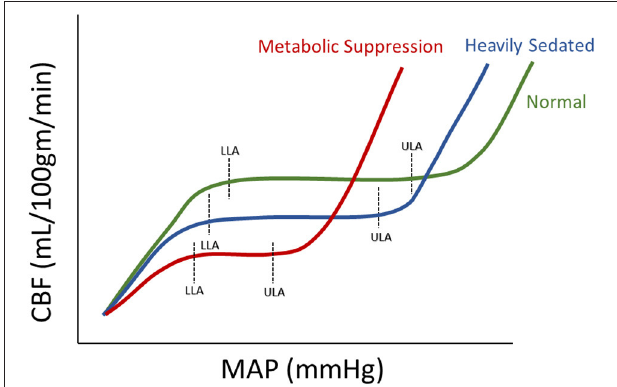
FIGURE 2 | Theoretical Autoregulation curve for Normal, Heavily Sedated, and Metabolically Suppressed Patients. The figure shows three therotical autoregulatory curves for three patient types: normal, heavily sedated and metabolically supressed. a.u., arbitray units; CBF, cerebral blood flow; LLA, lower limit of autoregulation; MAP, mean arterial blood pressure; ml/100 gm/min, milliliter per 100 grams per minute; mmHg, millimeters of mercury; ULA, upper limit of